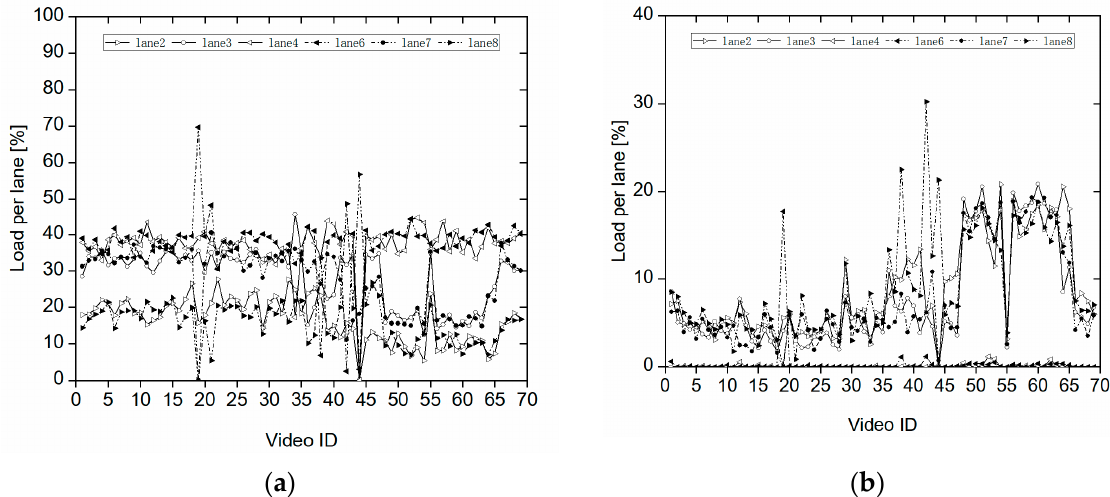
Figure 2. ( a ) Car load per lane of each lane in different videos; ( b ) Truck load per lane of each lane in different videos.